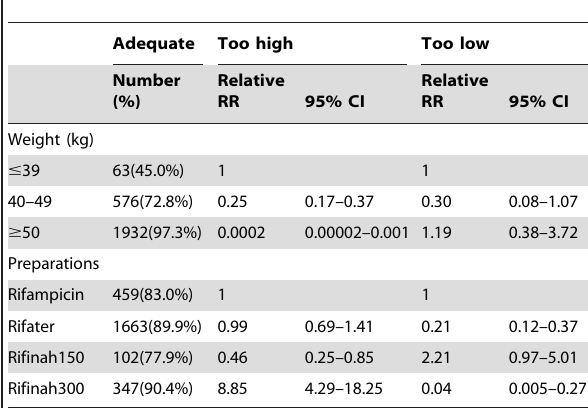
Table 2. Factors associated with inadequate dosing of rifampin among patients treated with Rifater, Rifinah, or Rifampicin in single-drug preparation, 2007–2010,